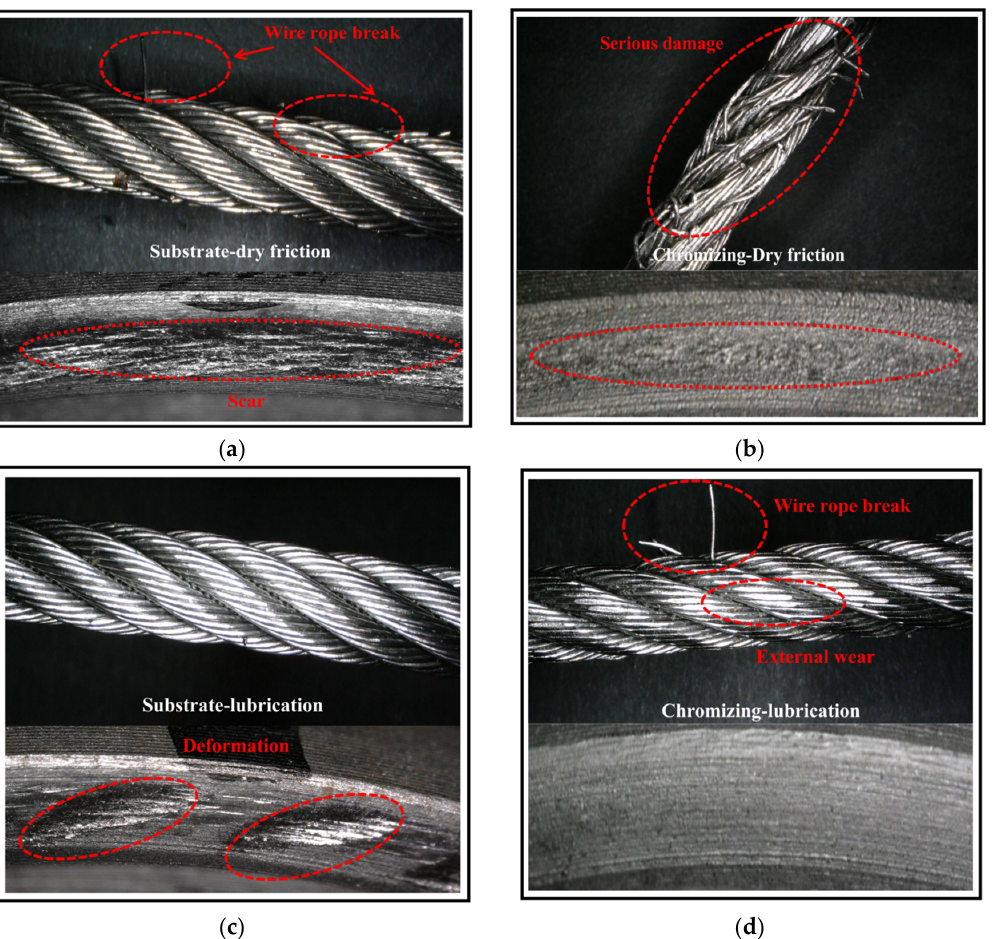
Figure 11. Wear morphology of the traction-wheel groove and wire rope under dry-friction and lubrication conditions. ( a ) Wear of rope–wheel with substrate only under dry-friction conditions. ( b ) Wear of rope–wheel with chromizing under dry-friction conditions. ( c ) Wear of rope–wheel with substrate only under lubrication conditions. ( d ) Wear of rope–wheel with chromizing under lubrication conditions.